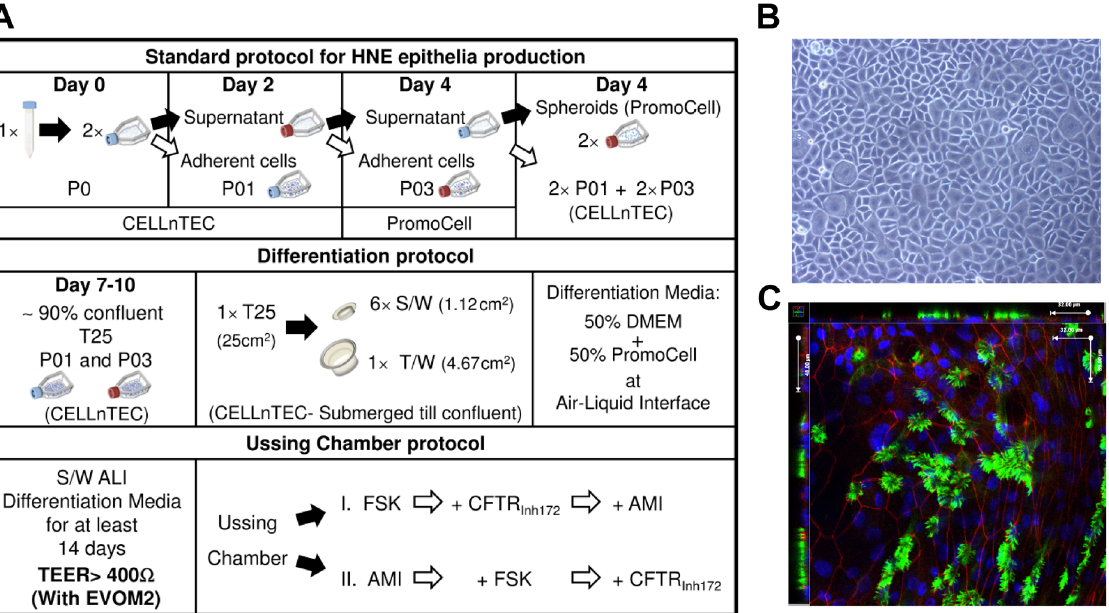
Fig 1. Human nasal epithelia in vitro reconstitution. (A) Schematic representation of cell culture protocol for expansion and differentiation of HNEs for Ussing Chamber experiments. (B) Typical HNE monolayer obtained after 7 – 10 days in culture on collagen-coated flasks. (C) Immunofluorescence of ALI differentiated epithelia: representative acetylated tubulin (green) and ZO-1 (red) with DAPI counterstain (blue) performed after Ussing chamber experiment; 3D reconstruction from z-stack in adjacent left and top panel.